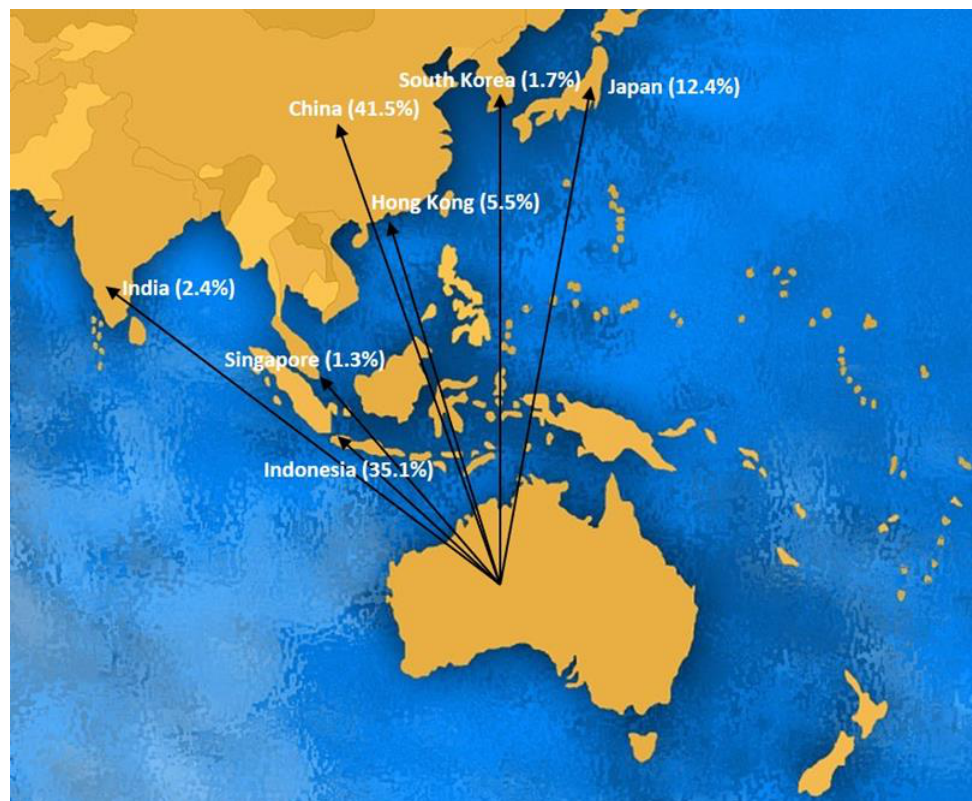
Figure 6. Relative quantities (mass-%) of e-waste shipped from Australia to be recycled in various international destinations in 2016. Data obtained from [37].